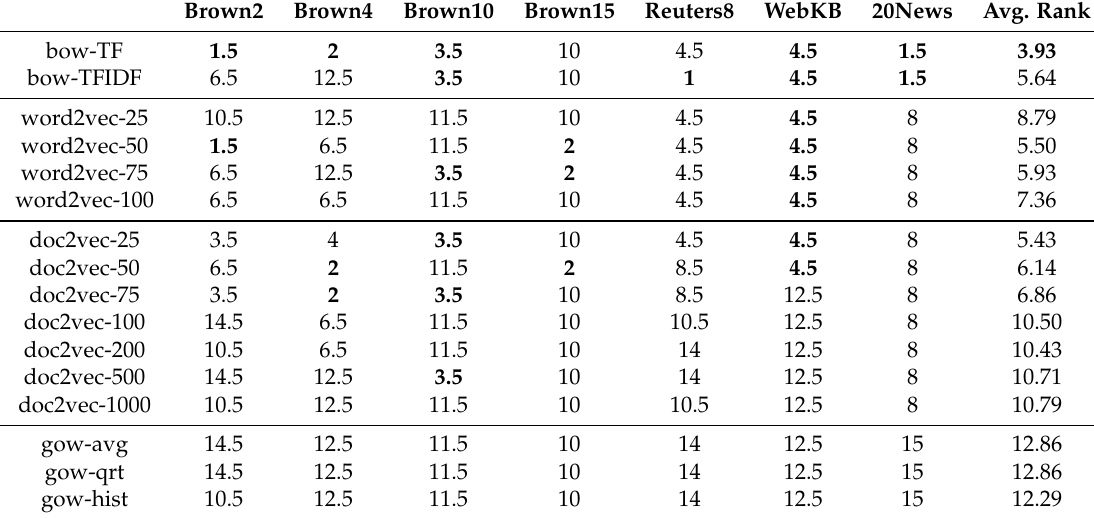
Table A1. Multi-objective ranking of the 16 variants of the three document representation models by document classification task with respect to precision. The last column reports the average rankings over the seven tasks. The top-ranked models in each column are shown in